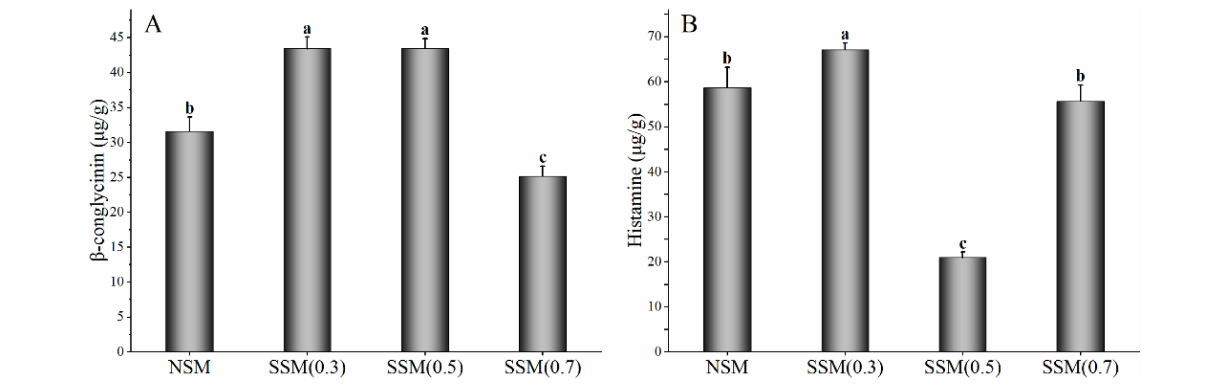
FIGURE 2 | The β -conglycinin and histamine content of soybean meal powder. (A) β -Conglycinin content. (B) Histamine content. NSM, native soybean meal; SSM, steam-exploded soybean meal, SSM (0.3), SSM (0.5), and SSM (0.7) indicated steam explosion pressure were 0.3, 0.5, and 0.7 MPa, respectively (means that do not share a letter are significantly different, p <